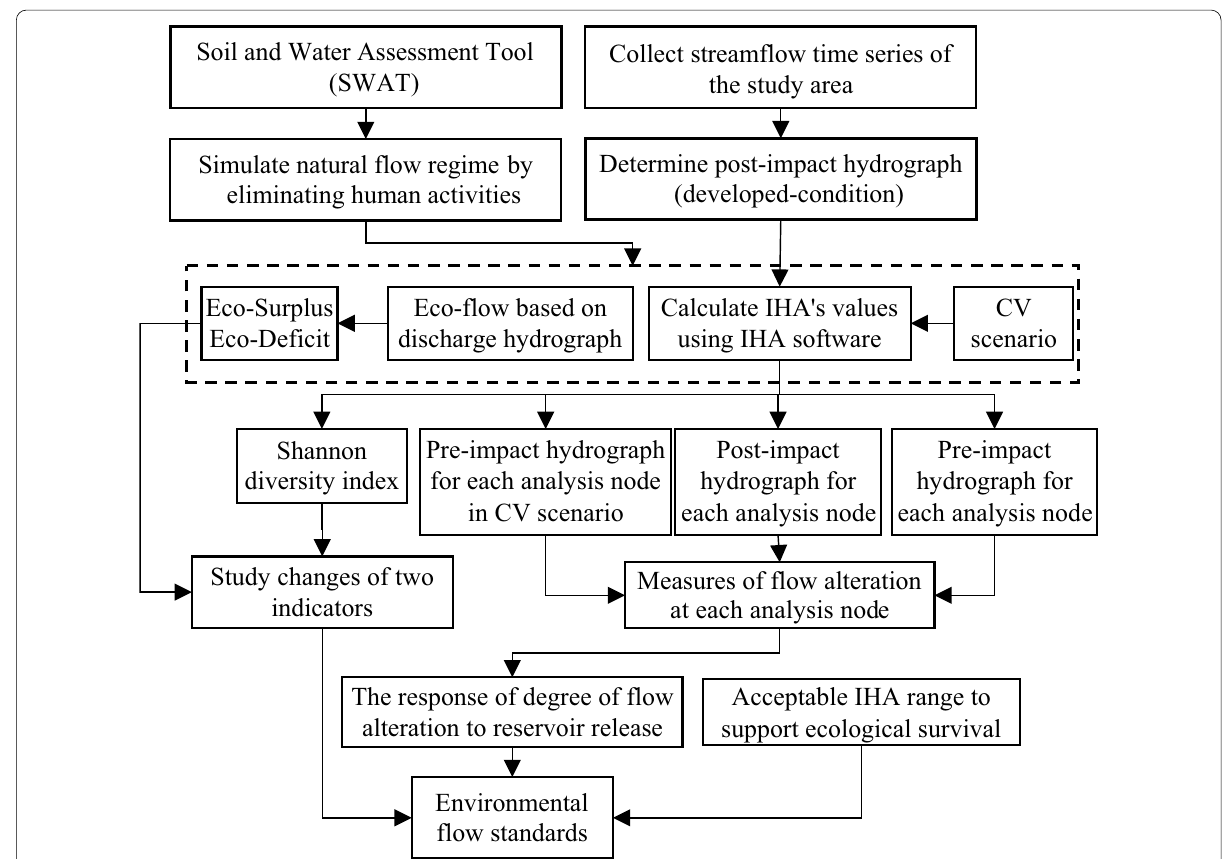
Fig. 2 Flow diagram of this study (CV: climate variability; IHA: indicators of hydrologic